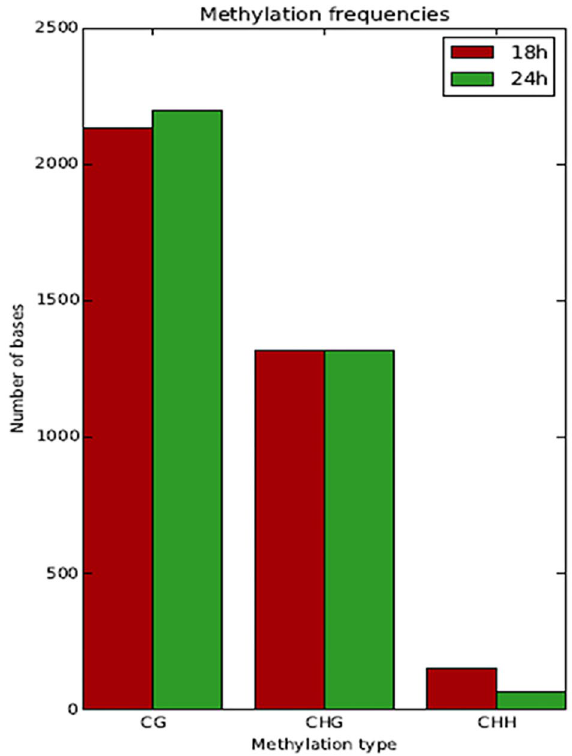
Figure 3. Number of methylated bases based on the CmG, CmHG, and CmHH motifs found in S. coelicolor M145 genome after 18 and 24 h of growth in MG. H stands for A, T, or